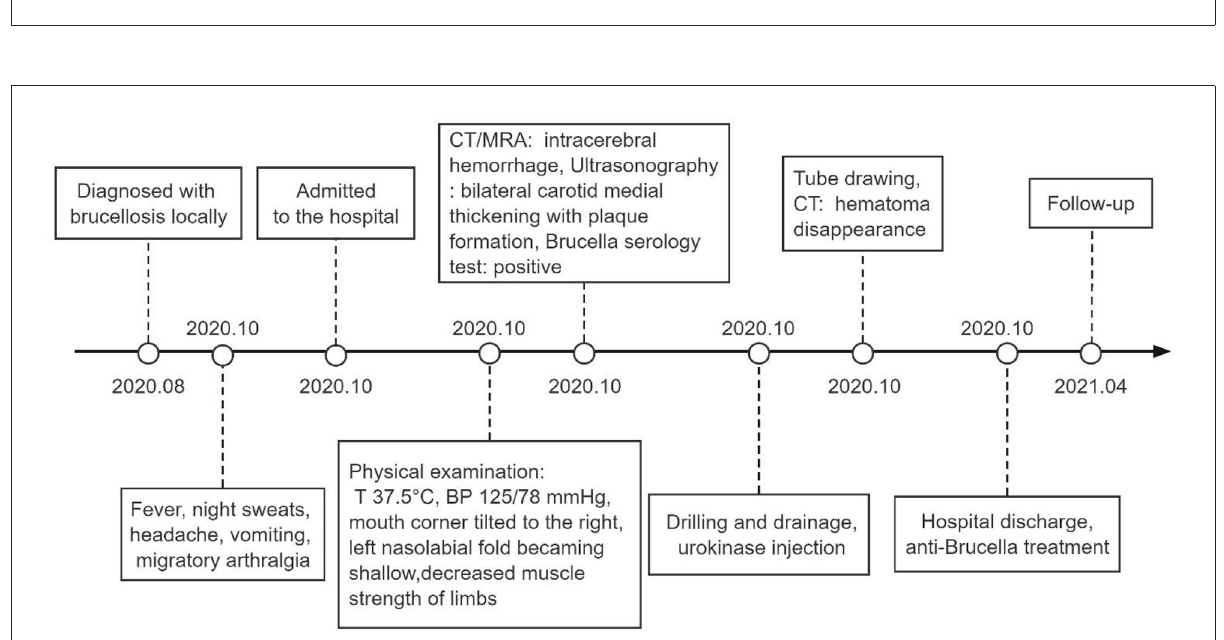
FIGURE4 Timeline. T, temperature; BP, blood pressure; CT, computed tomography; MRA, magnetic resonance angiography.